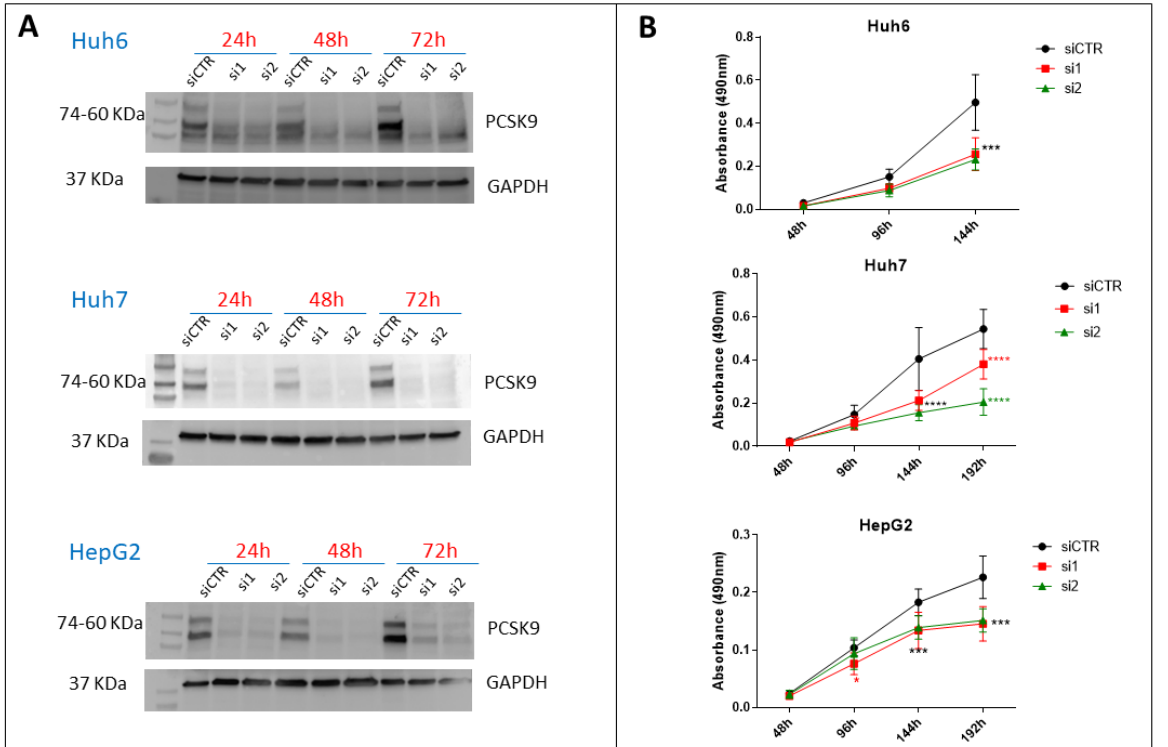
Figure 2. Effect of PCSK9 silencing by siRNA on liver cancer cell proliferation. ( A ) Validation of the depletion of PCSK9 by siRNA silencing. Cell extracts were prepared 24, 48 and 72 h after transfection with a control siRNA (siCTR) or targeting PCSK9 (si1 and si2) of Huh6, Huh7 or HepG2 cells. A total of 40 µ g of cell proteins were loaded per lane on an SDS-PAGE. After electrophoresis and transfer, the membrane was analyzed by Western blot using anti-PCSK9 and GAPDH antibodies for comparison of loading. The two bands observed for PCSK9 correspond to the pro-PCSK9 (74 kDa) and cleaved PCSK9 (60 kDa). ( B ) Evaluation of liver cancer cell proliferation by MTS after transfection with si1 and si2 in comparison with siCTR. Two-way ANOVA test, *** p < 0.001; **** p < 0.0001 (n = 3, with 3 technical replicates within each biological